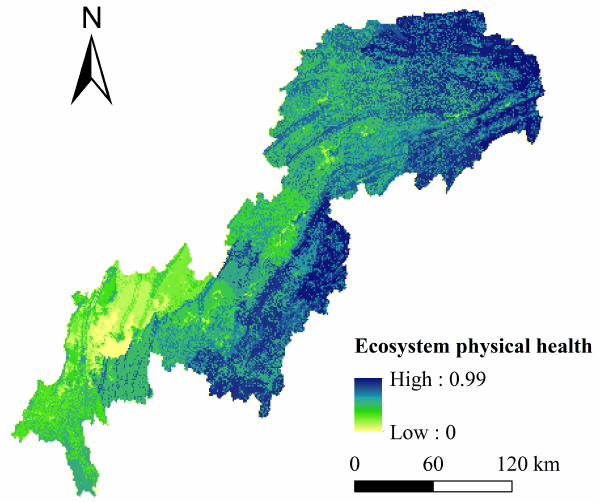
Figure 3. Spatial distribution of ecosystem physical health.